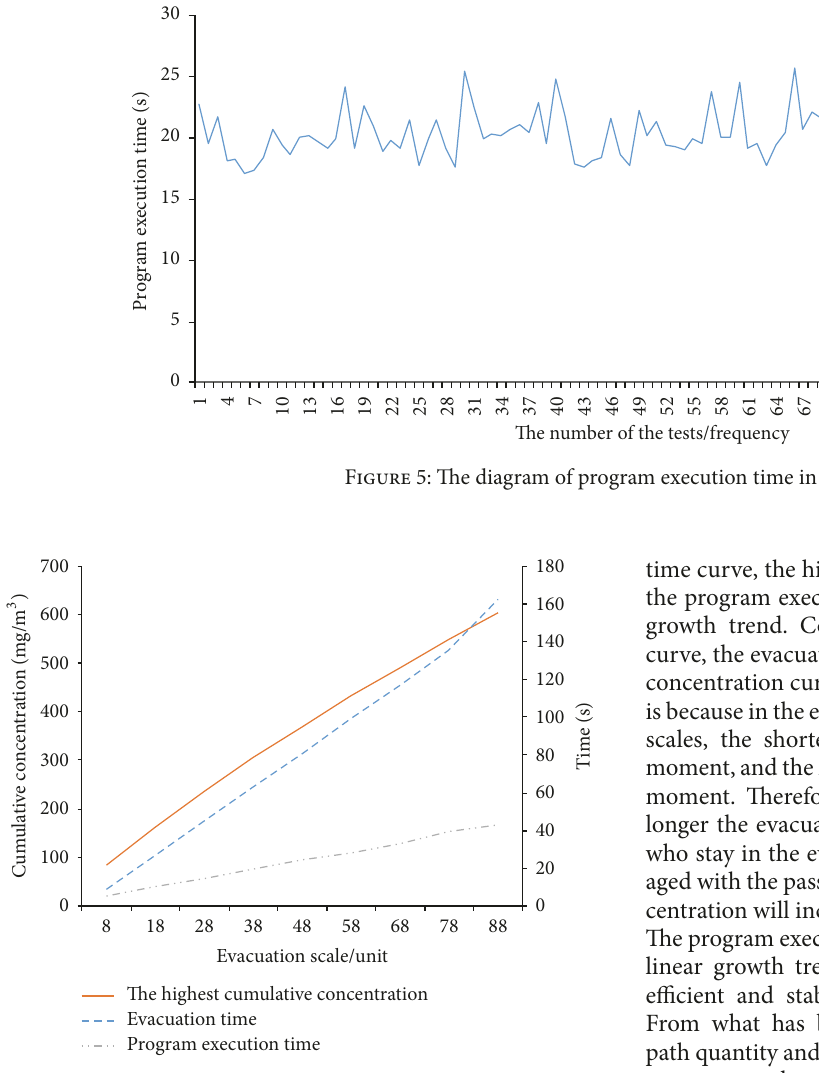
Figure 6: The results of different evacuation